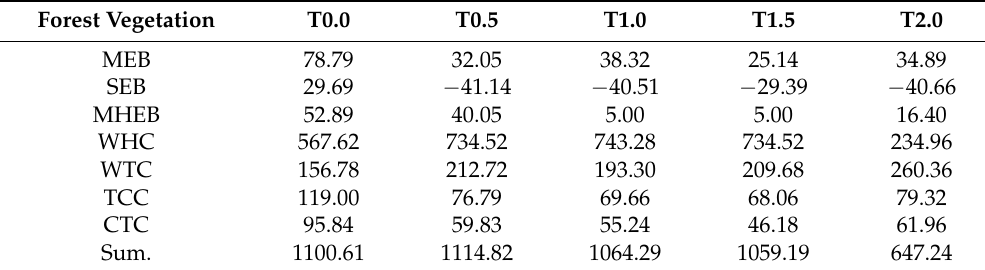
Table 6. The CSP of forest vegetation in Yunnan Province (Unit: TgC). Forest